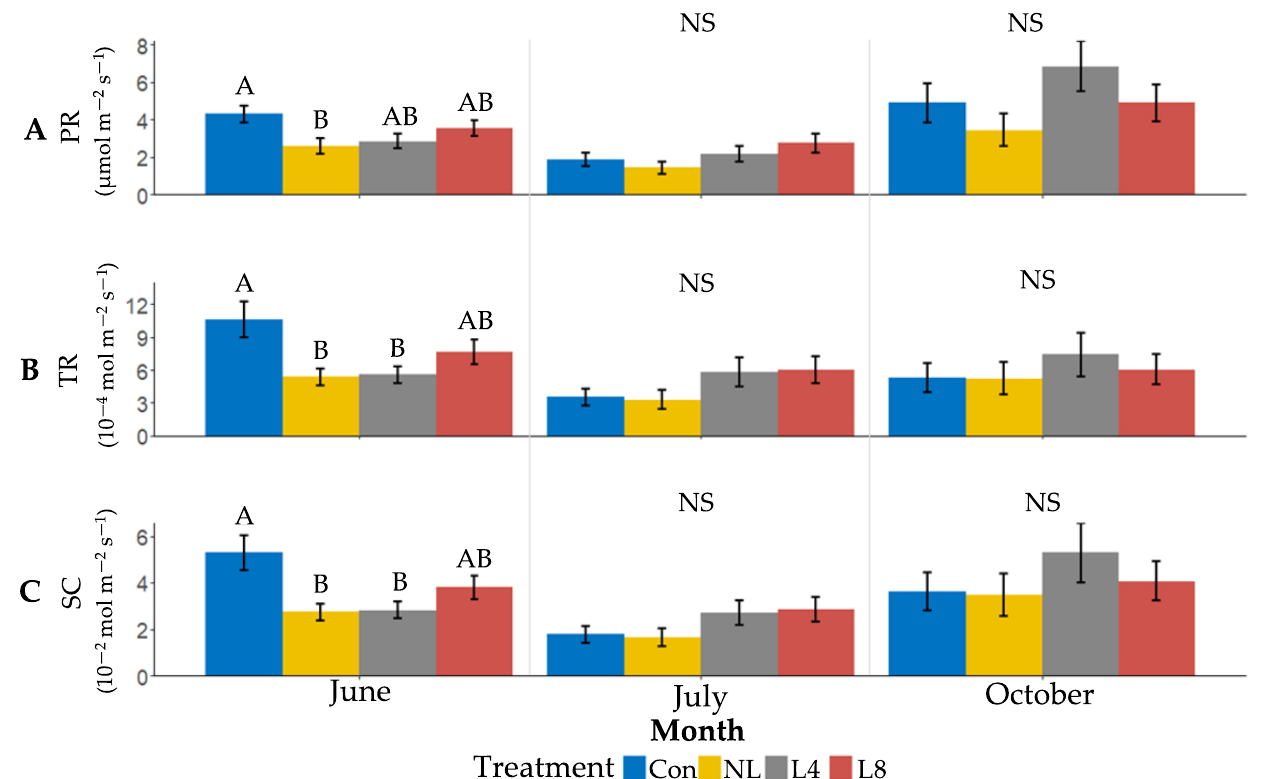
Figure 4. Experiment 2—Tree Physiological Measurements. ( A ) Model adjusted mean (+/ − SE) photosynthetic rate (PR) across treatments for June, July, and October. Different letters above standard error bars indicate significant ( p < 0.05) differences, Tukey post hoc adjustment. Statistical analyses are separated by month. ( B ) Model adjusted mean (+/ − SE) transpiration rate (TR) across treatments and separated by month. Letters NS above standard error bars indicate no significant ( p < 0.05) differences. Statistical analyses are separated by month. Units were converted to 10 −4 for easier viewing. ( C ) Model adjusted mean (+/− SE) stomatal conductance (SC) across treatments for June, July, and October. Units for stomatal conductance were converted to 10 —2 for easier viewing. Letters NS above standard error bars indicate no significant ( p < 0.05) differences. Statistical analyses are separated by month. All measurements were taken on eastern hemlock. Con = no predators at low HWA densities (<1/cm), NL = no predators at moderate to high HWA densities (<1 HWA/cm), L4 = 4 and L8 = 8 L. nigrinus at moderate to high HWA densities.